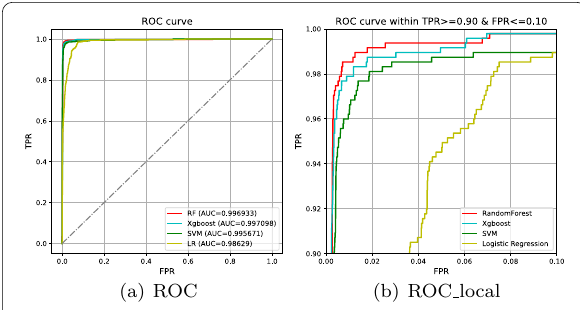
Fig. 10 ROC and AUC analysis. ( a ) Prediction ROC changes. ( b ) Prediction ROC changes within the TPR>